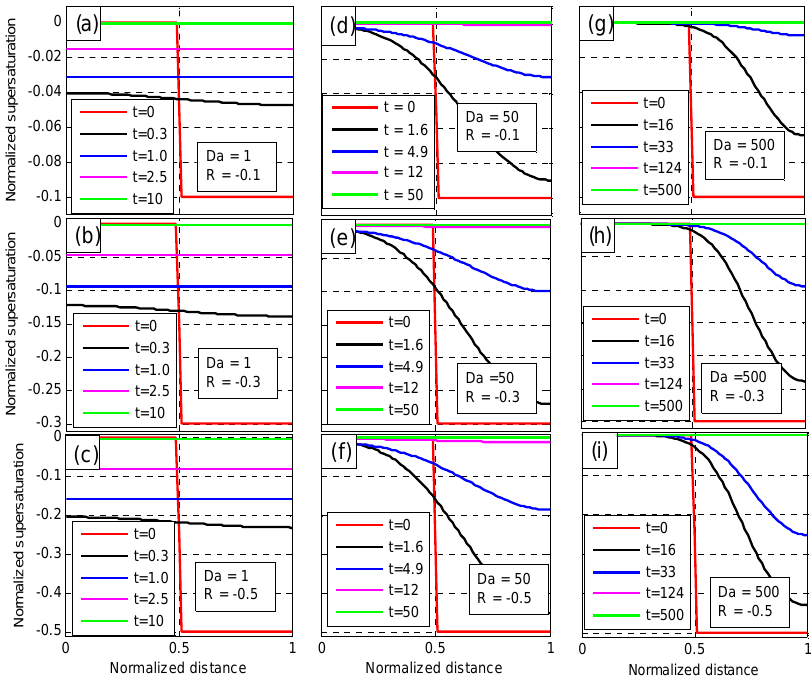
Figure 7. Profiles of normalized supersaturation at different Da and different R > −